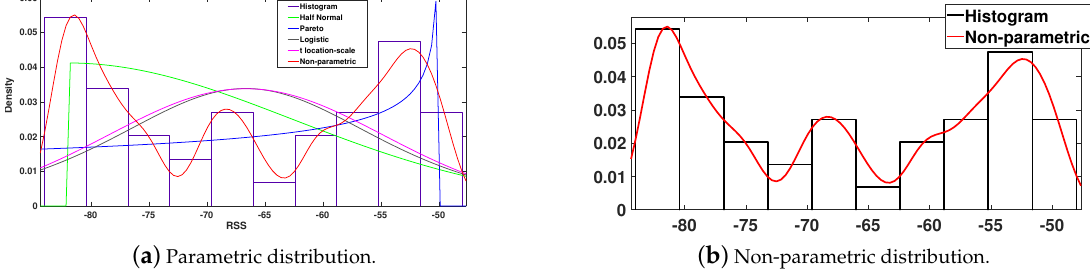
Figure 3. Fitting of parametric distributions in ( a ) and a KDE of Gaussian kernel in ( b ), of real data